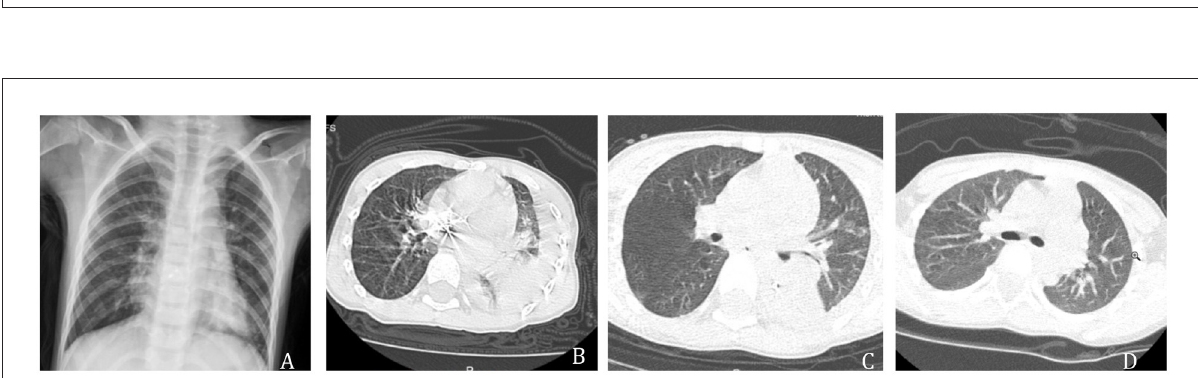
FIGURE2 (A) Pre-admission outpatient chest X-ray showed inflammation in both lungs. (B) On admission, chest CT showed inflammation in both lungs, partial atelectasis in the left lower lobe, and left pleural effusion. (C) Three days after closed chest drainage, a chest CT showed localized progression of inflammation in both lungs, partial atelectasis in the left lower lobe, and resorption of left pleural effusion. (D) Eighteen days after antibiotic treatment, chest CT showed improvement of the inflammation in both lungs, and a small amount of pleural effusion on the left side.